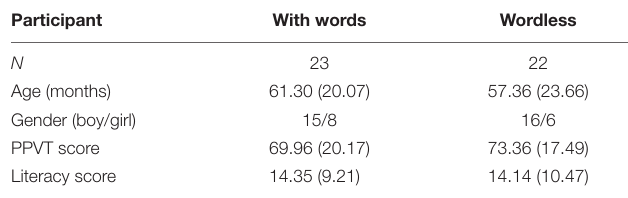
TABLE 1 | Characteristics of the participating children ( M /( SD